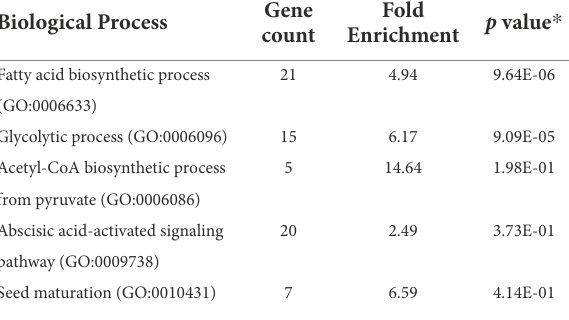
TABLE 4 GO term enrichment for 889 A. thaliana genes for which the AW-box is present in the 500 bp upstream region and conserved in at least 5 out of the 11 other species